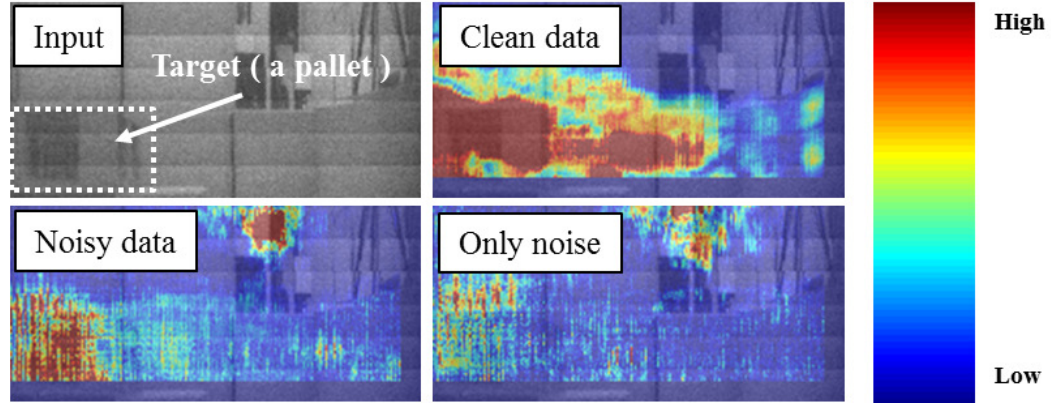
Figure 2. Difference in important